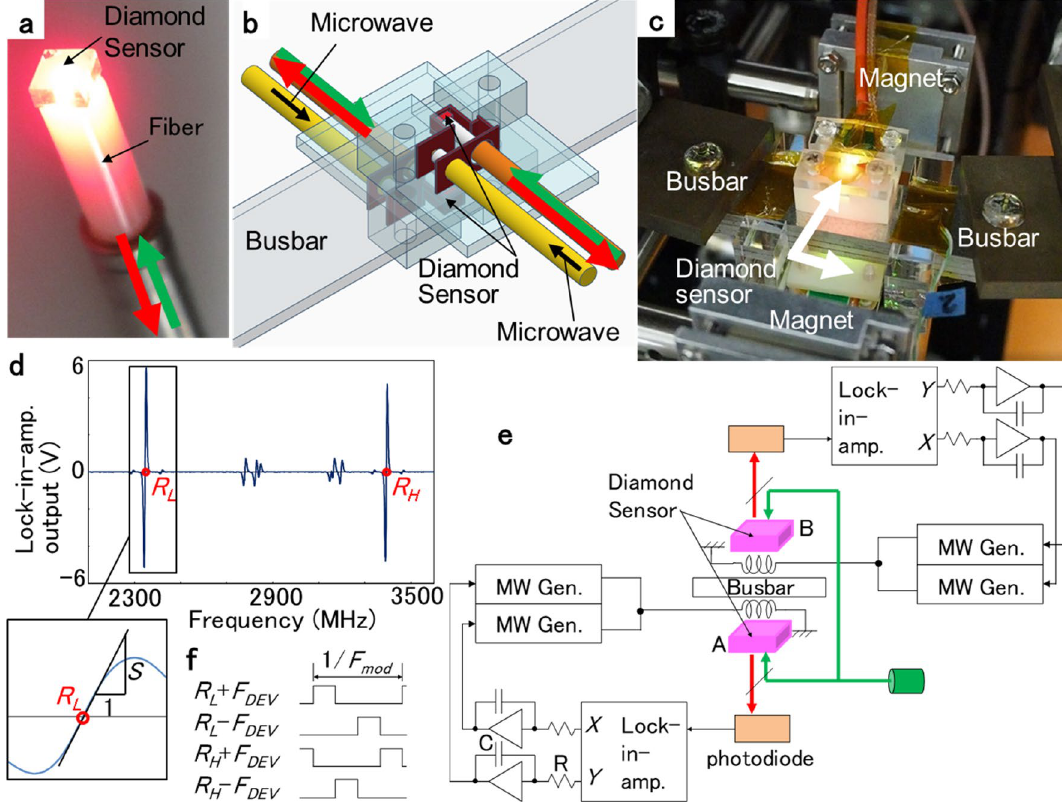
Figure 2. Prototype busbar current differential detection system. ( a ) 2 × 2 × 1 mm 3 diamond sensor adhered to one end of a fiber. ( b ) Sensors A and B placed on both sides of the busbar for differential detection. ( c ) Photograph of sensors and busbar placed between a pair of magnets. ( d ) ODMR spectrum of the diamond sensor with the resonance frequency difference of the [111] NV − , R H − R L = 1050 MHz. S is illustrated as the slope of the ODMR at R L and R H . ( e ) Block diagram of the busbar current measurement system. The lock-in- amplifier output difference Y – X is integrated to control the two microwave generator frequencies to trace the low and high resonance frequency. ( f ) Time division microwave frequency modulation for a lock-in-amplifier to reflect the magnetic field as its differential output. Four frequencies R L ± F DEV and R H ± F DEV generated by ± F DEV are provided within one cycle of F MOD without